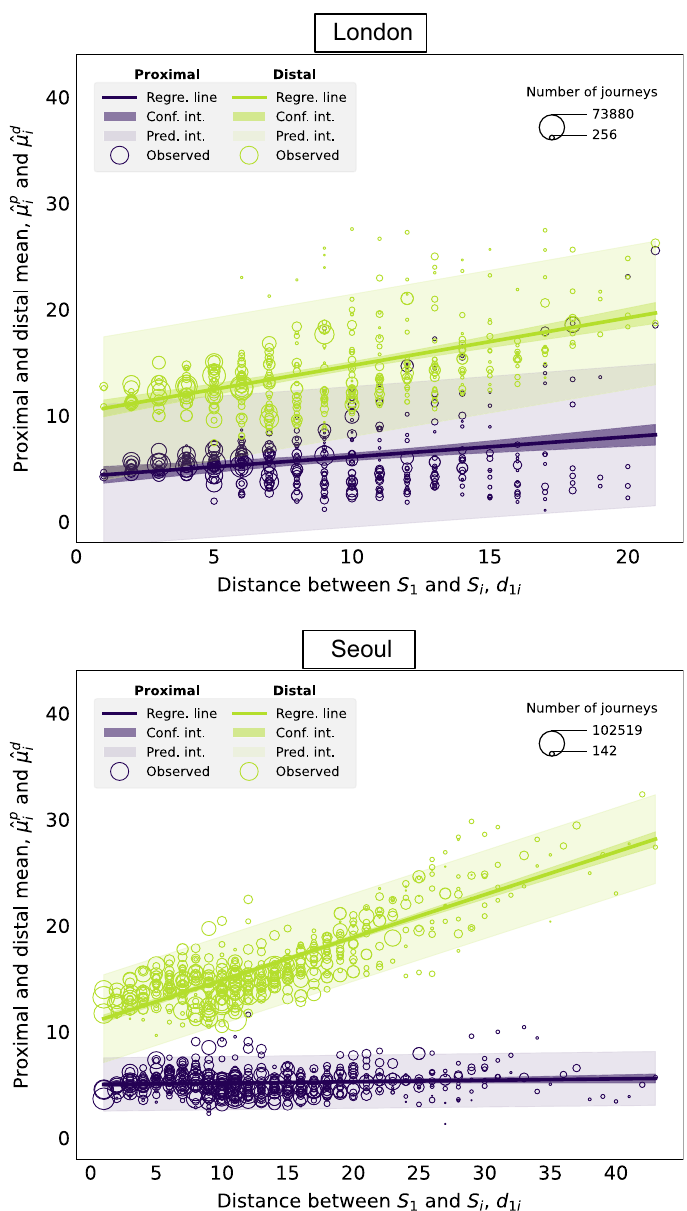
Figure 4. Relationship between the proximal and distal mean of the distribution of journeys terminating at p ˆ µ d d 1 i between the nucleus S 1 and the destination station S i . each station, ˆ µ i and i , and the distance